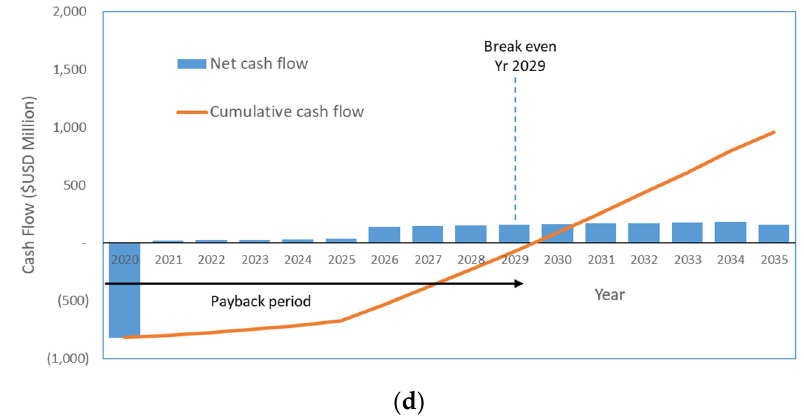
Figure 5. ( a ) Project cash flow base case using polymeric membrane. ( b ) Project cash flow using chemical absorption (Amine). ( c ) Project cash flow using physical absorption solvent (Selexol). ( d ) Project cash flow using cryogenic distillation.